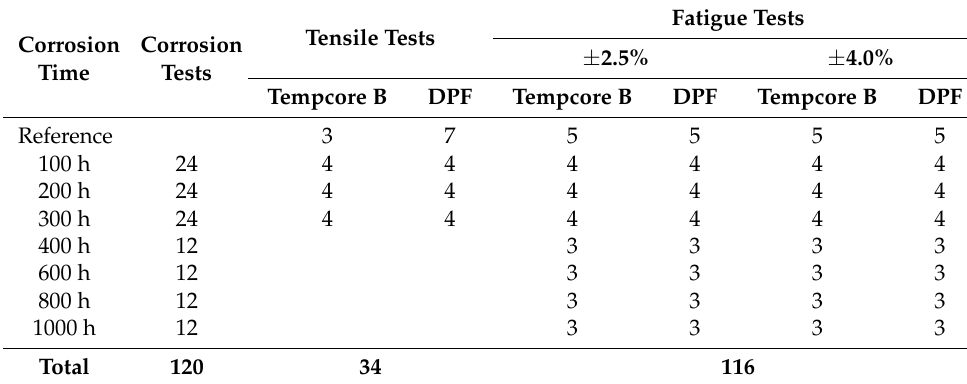
Table 2. Test matrix for Tempcore B and Dual Phase F (DPF)